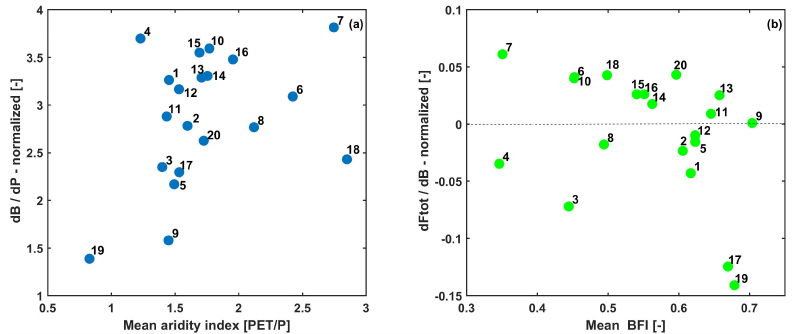
Figure 5. (a) Normalized baseflow ( B ) sensitivities to annual precipitation ( P ) in each catchment with non-stationary hydrologic response against its mean aridity index (1984–2010), (b) normalized annual fractional vegetation cover ( F tot ) sensitivities to annual baseflow of each catchment with non-stationary hydrologic response against its mean baseflow index (BFI) (1984–2010). Data labels refer to the station identification number in Table 1. In general, annual baseflow sensitivities to mean annual precipitation decrease in wetter catchments (smaller aridity index). Positive sensitivities of fractional vegetation cover to baseflow decrease in catchments with higher baseflow index. Negative fractional vegetation cover sensitivities to baseflow become more negative in catchments with higher baseflow index, indicating larger contribution of groundwater to